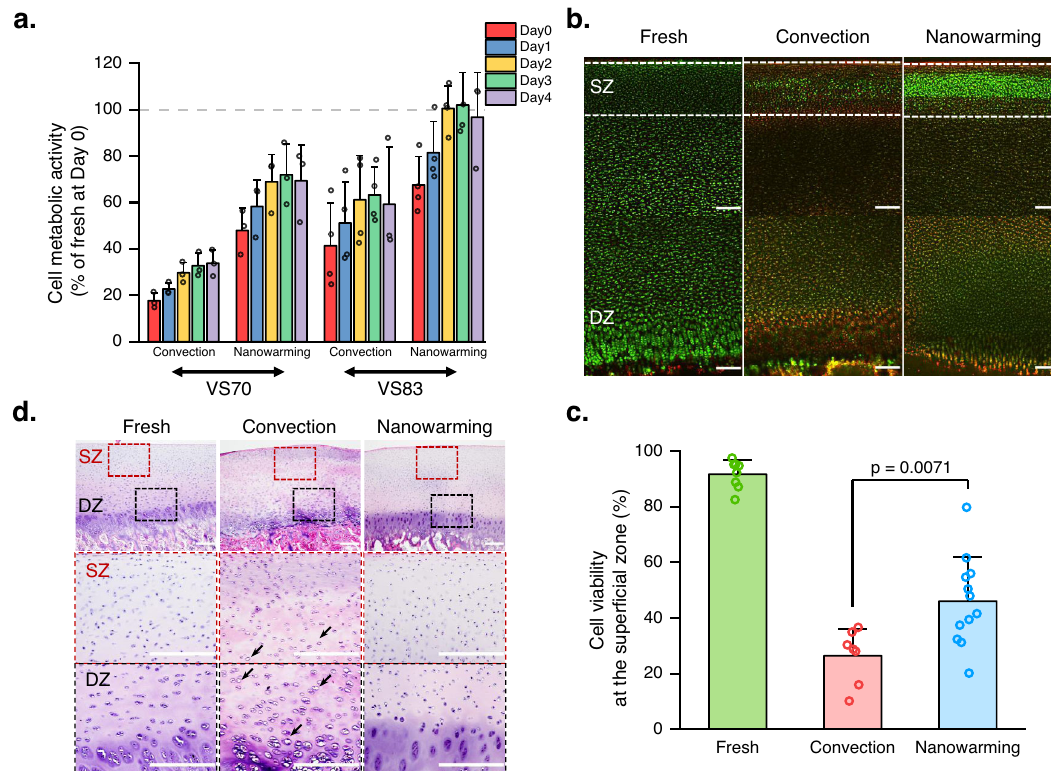
Fig. 2 Nanowarming outperforms convection warming in retaining cell function for large OCA preservation. a Cell metabolic activity results were measured by alamarBlue assay. The results were normalized to the value of fresh control cartilage measured at day 0 of each batch experiment. The gray dashed line indicates 100% recovery, reaching the level of cell metabolic activity of fresh cartilage ( n = 3 independent samples for both convection and nanowarming groups with VS70 solutions. n = 4 independent samples for both convection and nanowarming groups with VS83 solutions). b Representative fl uorescence live/dead staining results measured with samples collected immediately after rewarming. SZ super fi cial zone, DZ deep zone. The white dashed line indicates the super fi cial region for the quanti fi cation analysis of cell viability shown in ( c ). Scale bars represent 200 μ m. c Cell viability quanti fi ed at the super fi cial layer of fl uorescence live/dead staining images in fresh ( n = 8 independent samples), convection ( n = 7 independent samples), and nanowarming ( n = 12 independent samples) cartilages. p -value was determined with one-way ANOVA with Bonferroni post-hoc test. d Representative Hematoxylin & Eosin (H&E) staining images of fresh, convection, and nanowarming cartilages were collected immediately after rewarming. SZ super fi cial zone, enlarged image shown in the red dashed box; DZ deep zone, enlarged image shown in the black dashed box. Scale bars represent 200 μ m. The black arrows highlight locations with white space, indicating possible ice formation. All data depict mean ± standard deviation. Note: mIONPs in the nanowaming group are loaded through the immersion approach for all data presented